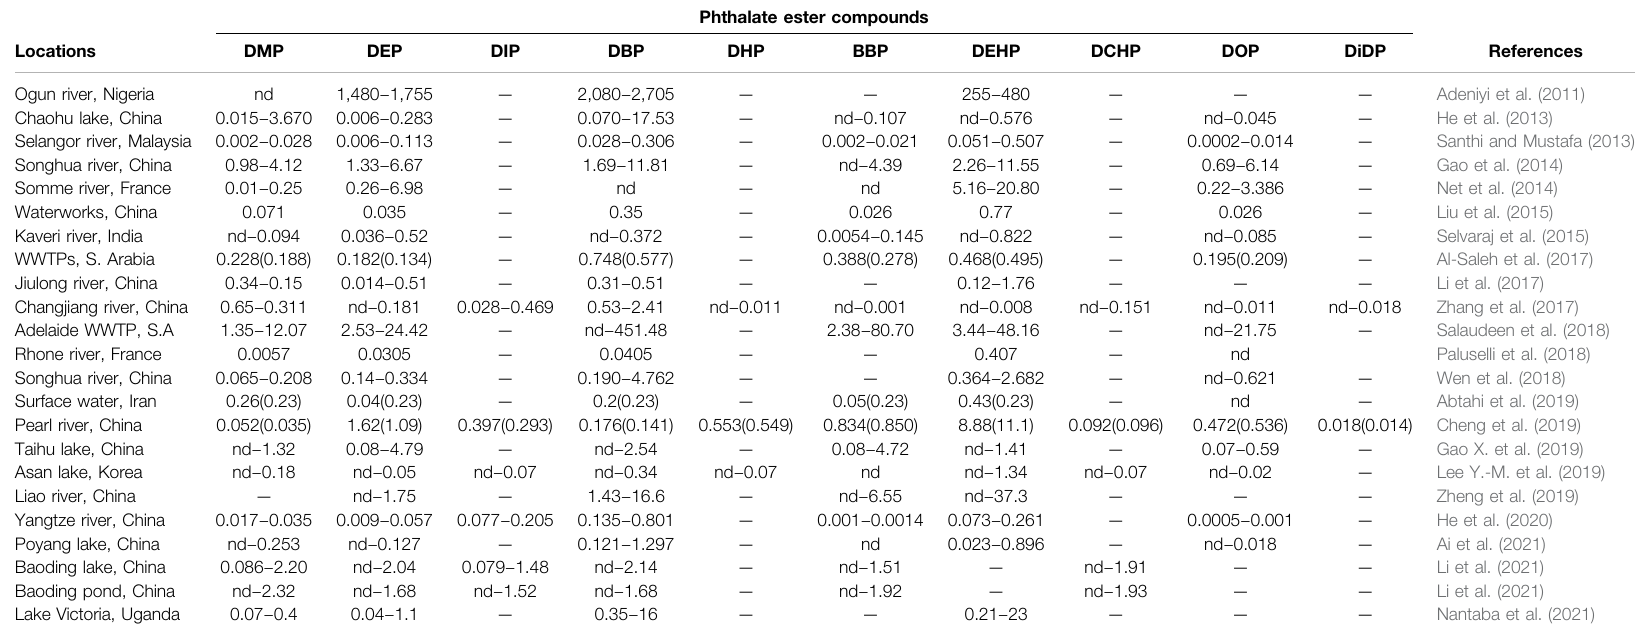
TABLE 2 | Mean (RSD)/range concentrations of some PEs in environmental water samples ( μ g/L).